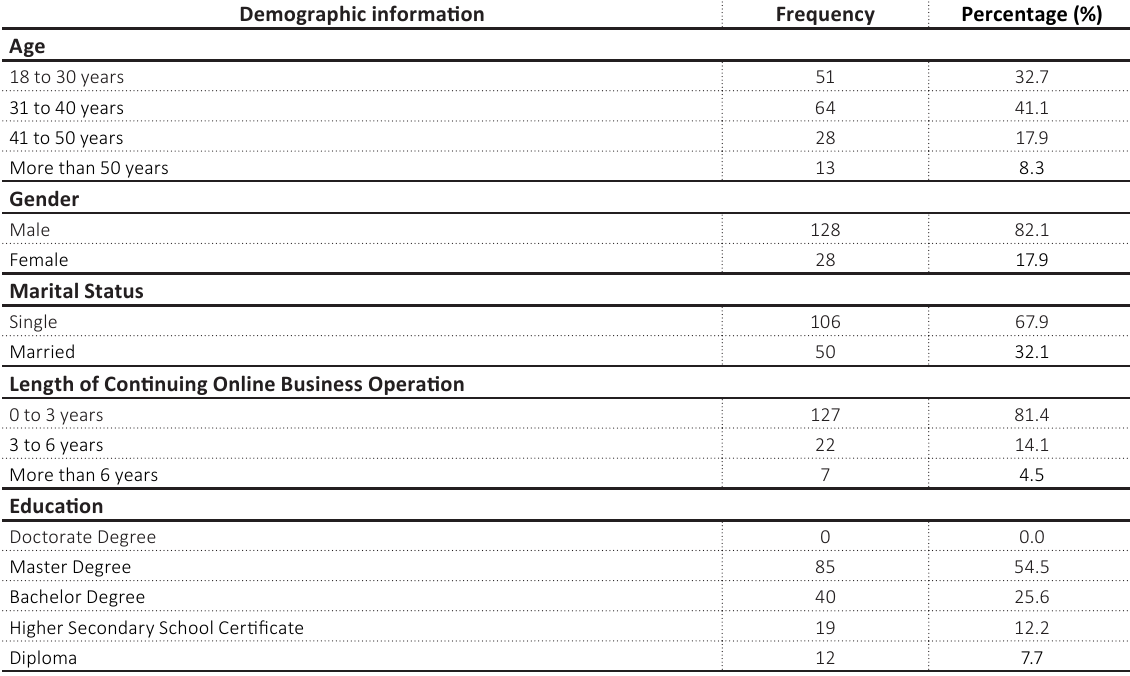
Table 1. Demographic information about online SME